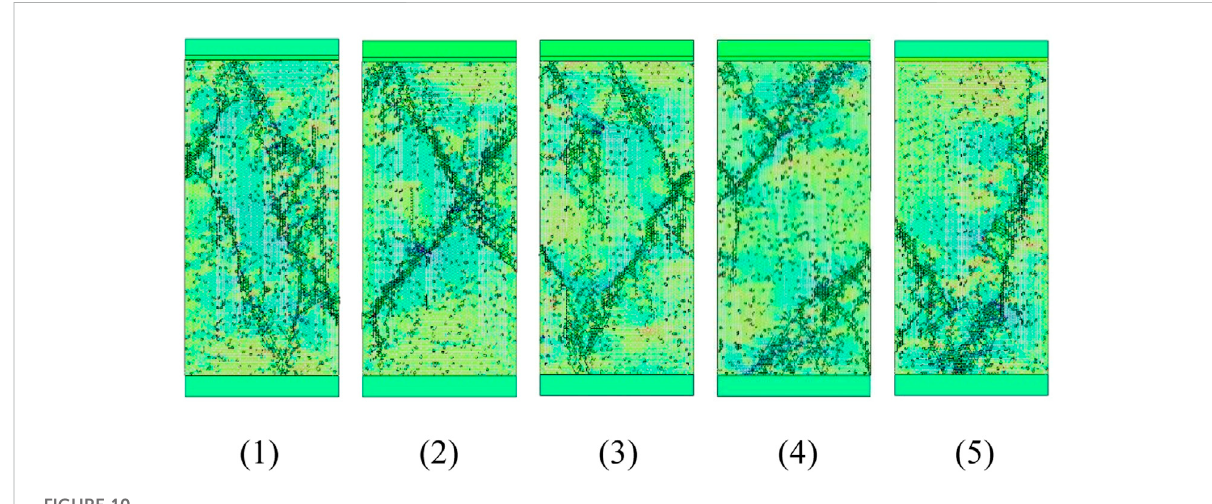
FIGURE 10 Fracturing failure patterns of the intact rectangular specimen with m = 5 (Ning et al.,